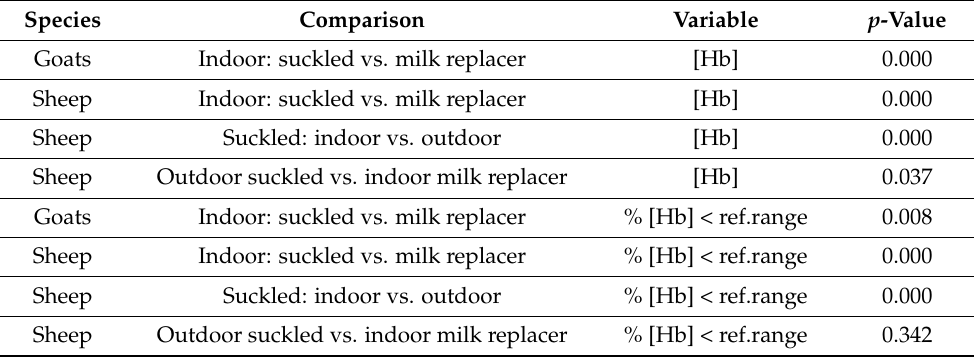
Table 3. Results of the comparison of the concentration of haemoglobin by Student’s t -test, and the comparison of the percentage of animals with haemoglobin concentration below the reference range by Fisher’s exact test between the different groups. Cross-species comparisons were not performed. Species Comparison Variable p -Value Goats Indoor: suckled vs. milk replacer [Hb] 0.000 Sheep Indoor: suckled vs. milk replacer [Hb] 0.000 Sheep Suckled: indoor vs. outdoor [Hb] 0.000 Sheep Outdoor suckled vs. indoor milk replacer [Hb] 0.037 Goats Indoor: suckled vs. milk replacer % [Hb] < ref.range 0.008 Sheep Indoor: suckled vs. milk replacer % [Hb] < ref.range 0.000 Sheep Suckled: indoor vs. outdoor % [Hb] < ref.range 0.000 Sheep Outdoor suckled vs. indoor milk replacer % [Hb] < ref.range 0.342